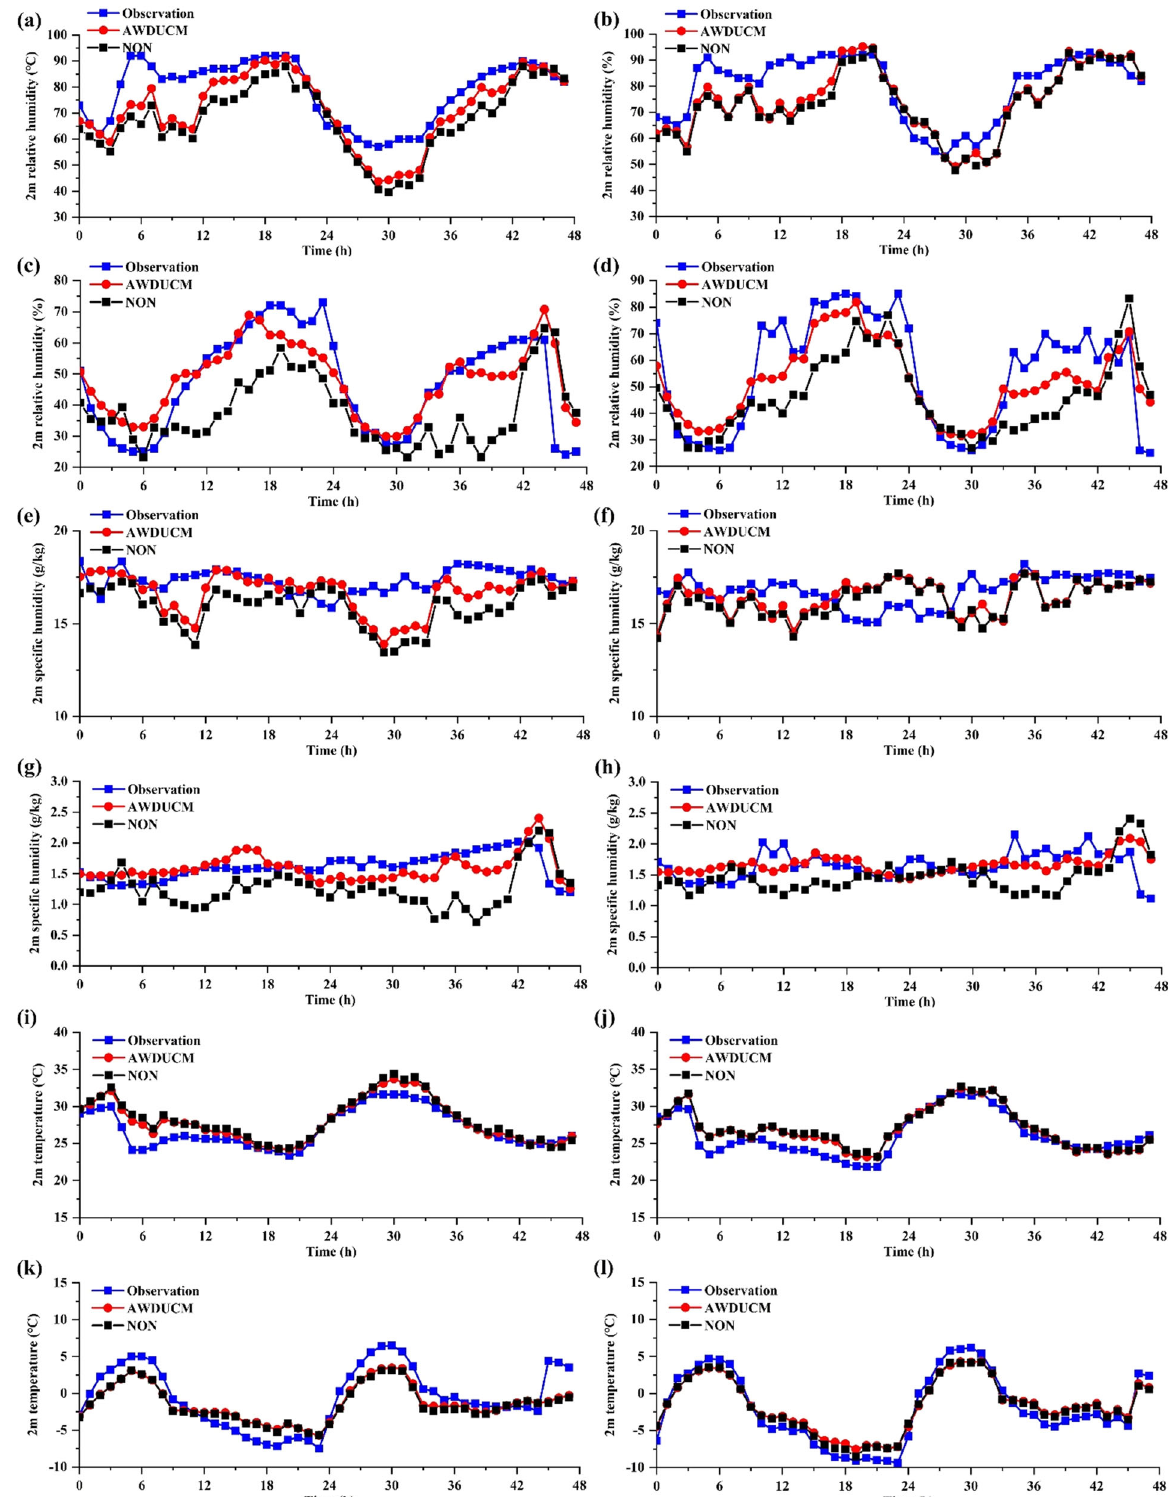
Fig. 4 Comparison with observations and simulations. Comparison of observed and simulated (AWDUCM and NON) 2 m relative humidity, speci fi c humidity, and temperature at Beijing station ( a , e , and i ) and Fangshan station ( b , f , and j ) during summer, and Beijing station ( c , g , and k ) and Fangshan station ( d , h , and l ) during